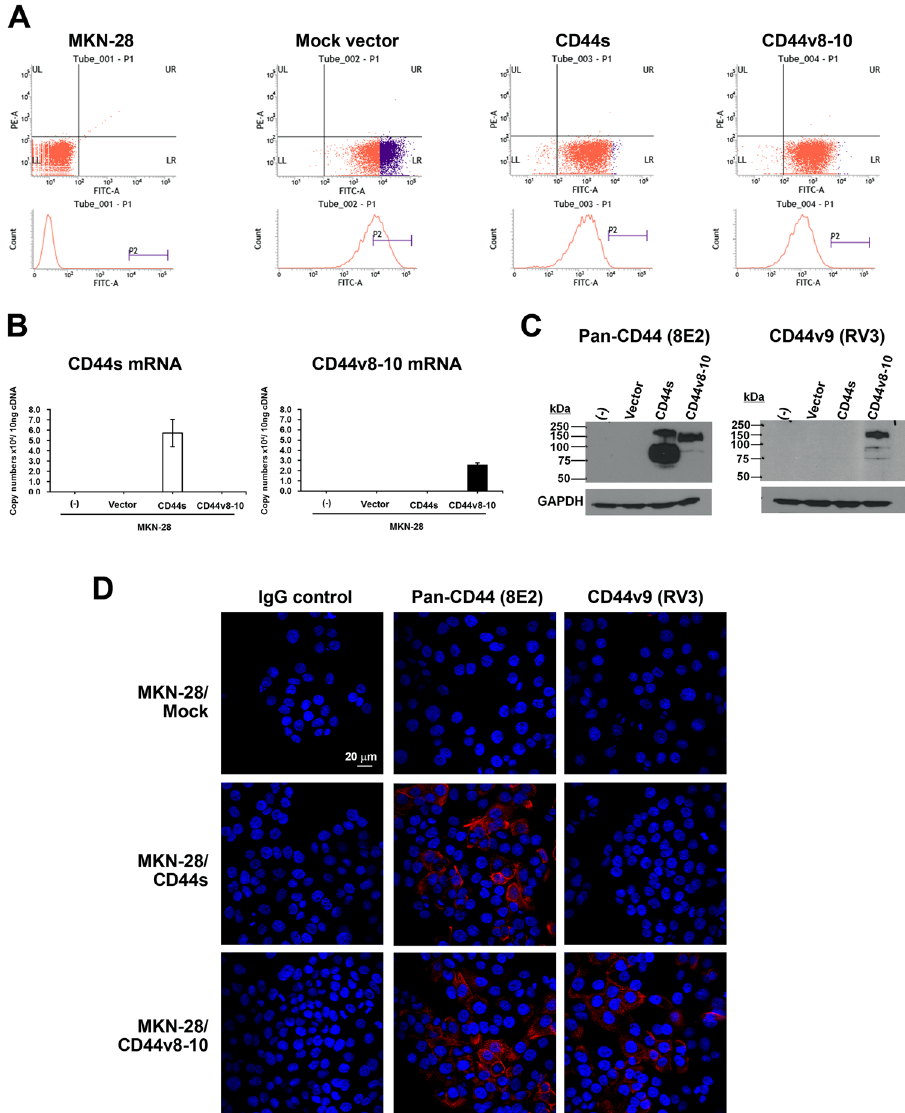
Figure 3. Establishment of stably CD44s and CD44v8-10expressing cells. ( A ) Stable expression of GFP-tagging open reading frame was confirmed by flow cytometry. ( B ) Expression of the stably expressed CD44s and CD44v8-10 was confirmed at mRNA level by qRT-PCR. ( C ) Protein level was confirmed by western blot using pan-CD44 antibody and CD44v9 antibody. ( D ) The location of CD44s and CD44v8-10 on MKN-28 cells was also confirmed by